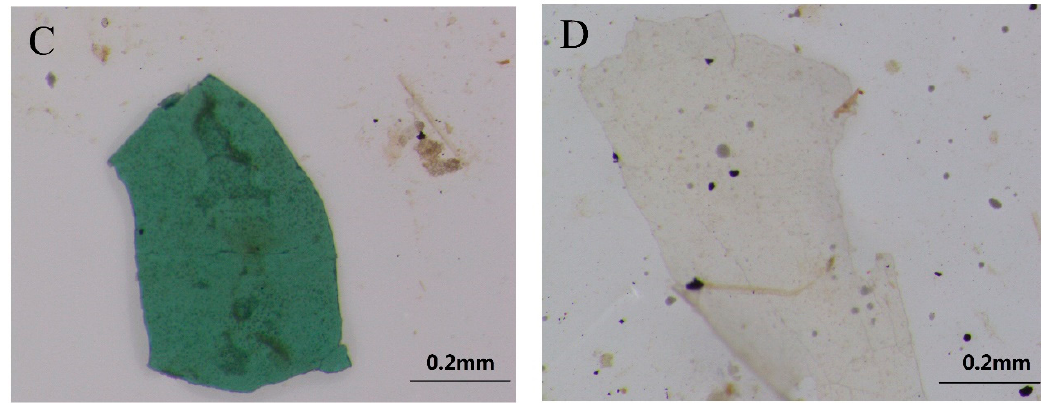
Figure 3. Typical photographs of microplastics: ( a ) line, ( b ) foam, ( c ) fragment, ( d ) film.